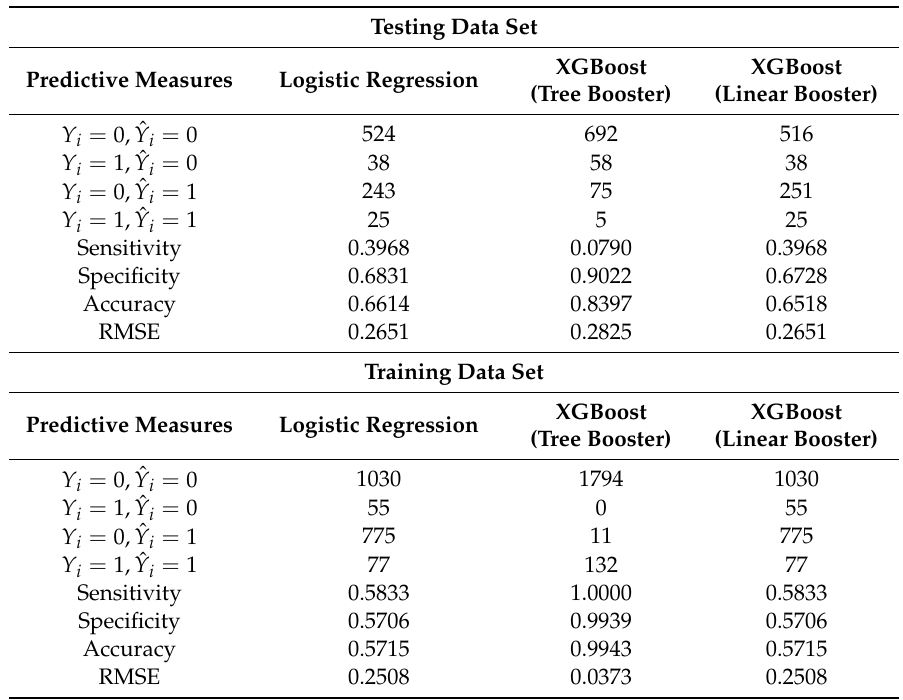
Table 3. The confusion matrix and predictive measures of the logistic regression, XGBoost with a tree booster and XGBoost with a linear booster for the testing and training data